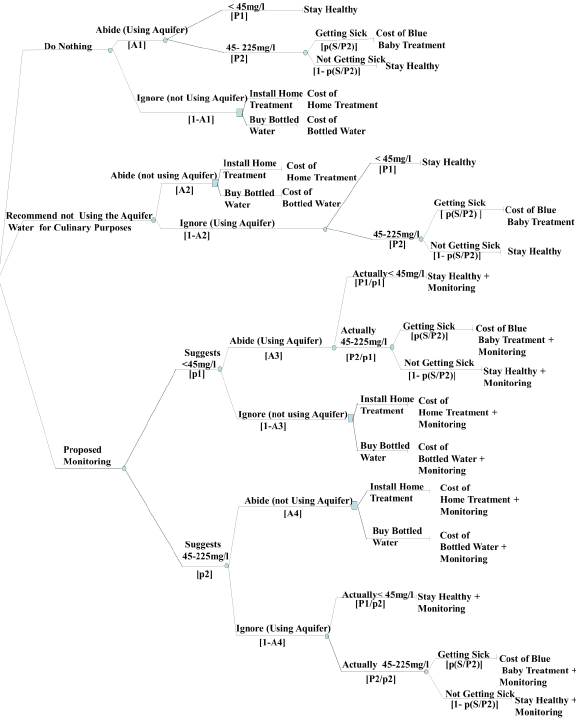
Fig. 4. Decision tree model for the scenario where some people Figure 4. Decision tree model for the scenario where some people abide by and others ignore abide by and others ignore DM DMs’ recommendations.